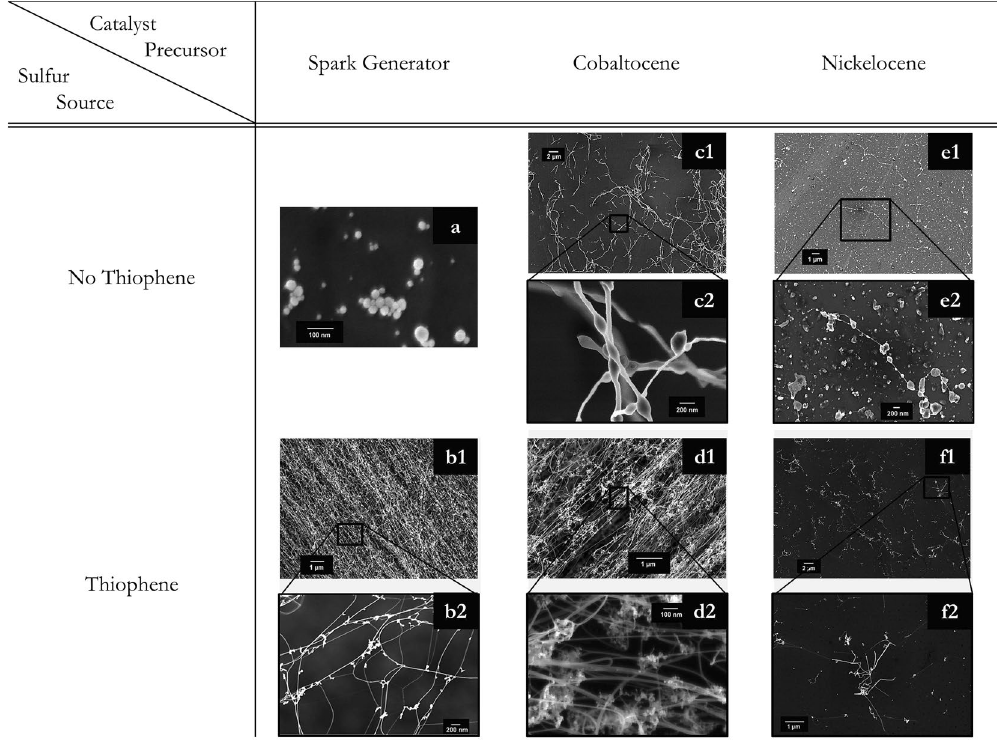
Figure 4. Overview of SEM images of samples resulting from different catalyst precursors – iron nanoparticles from a spark generator ( a – b2 ), cobalt nanoparticles from cobaltocene ( c1 – d2 ), nickel nanoparticles from nickelocene ( e1 – f2 ) and the addition of thiophene. For all reaction conditions shown, CH 4 was used as a carbon source. The actual concentrations are given in the Methods section of this